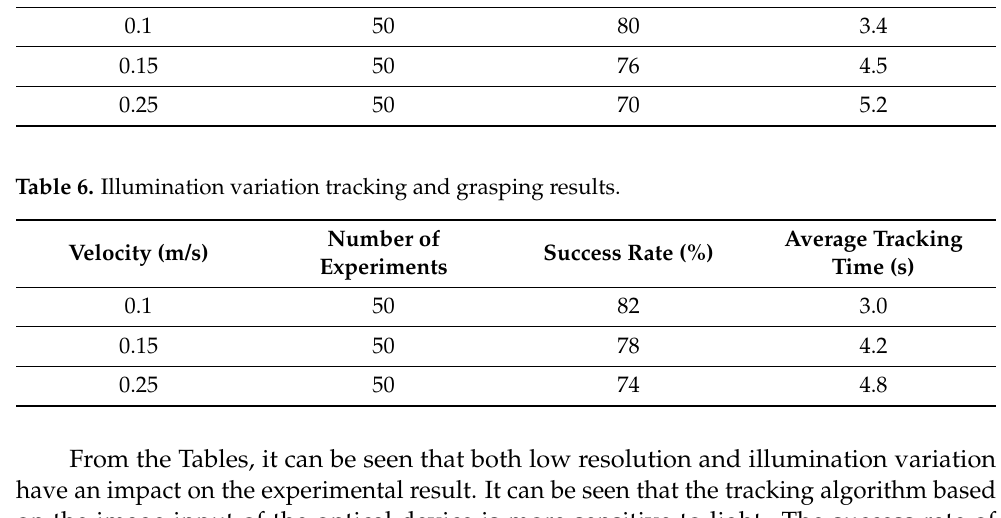
Figure 16. Experiments in illumination variation environment.